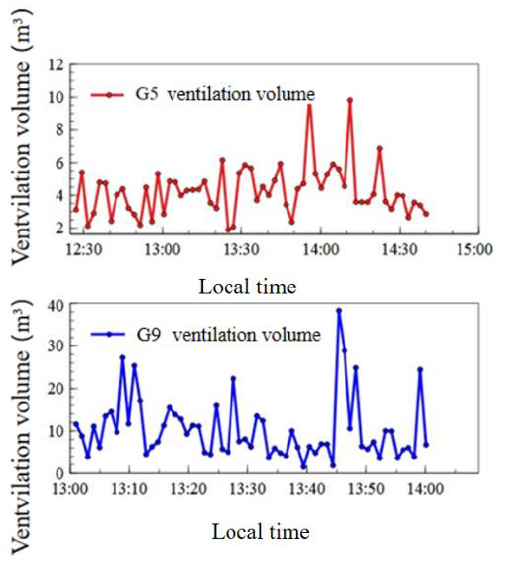
Figure 12. Inflow air volume data of G5 and G9.